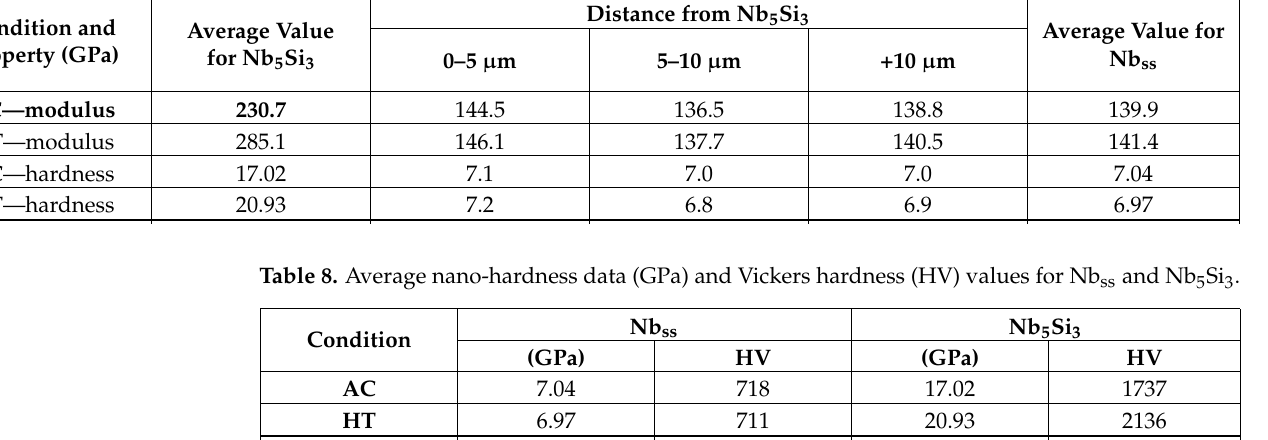
Table 7. Average modulus and hardness results from tests performed with a 7000 µ N load showing the changes of property with regard to the distance from the Nb 5 Si 3 ; data for as-cast (AC) and heat-treated (HT) conditions. Condition and Property (GPa)